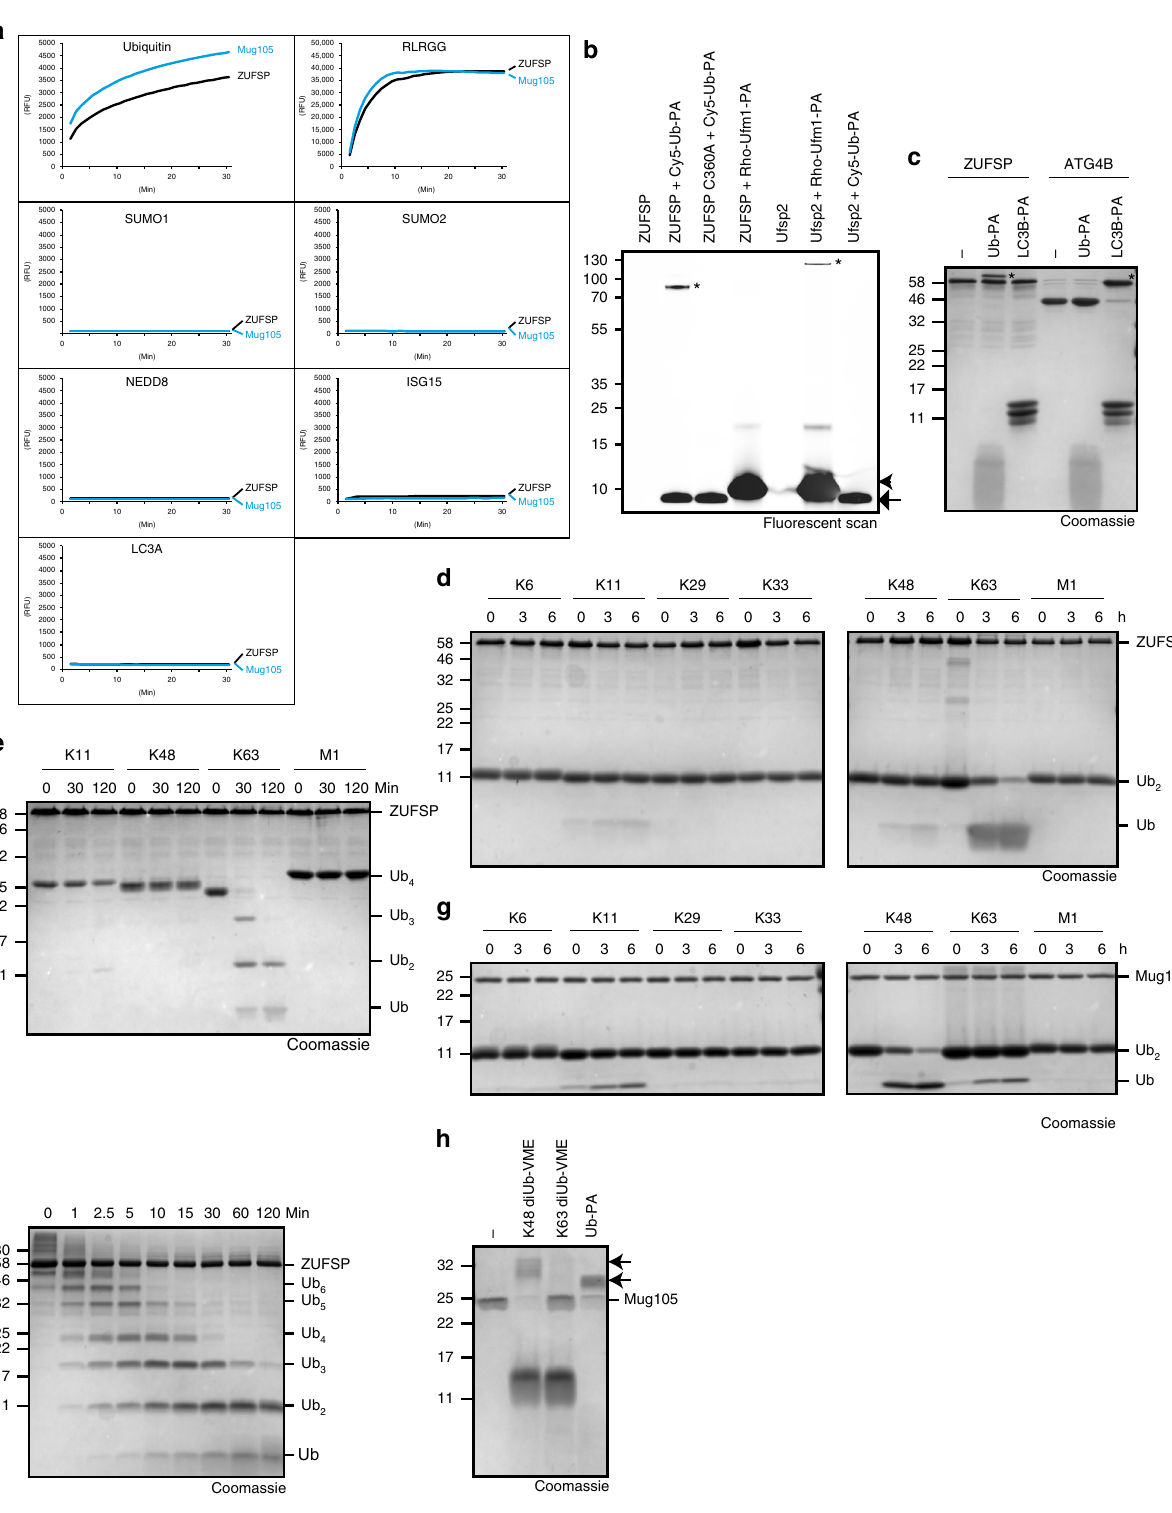
Fig. 2 ZUFSP and Mug105 are ubiquitin-speci fi c proteases with different chain speci fi city. a Activity assays with Ub-/UbL-AMC substrates shown as released fl uorescence (RFU) over time (min) with ZUFSP or Mug105. Shown RFU values are the means of triplicates. b Fluorescent scan of a suicide probe reaction of ZUFSP or Ufsp2 with Cy5-Ub-PA (arrow) and Rho-Ufm1-PA (arrowhead). Asterisks (*) mark the shifted band after reaction. c Suicide probe reaction of ZUFSP or ATG4B with Ub-PA and LC3B-PA. Asterisks (*) mark the shifted band after reaction. d , e Linkage speci fi city analysis with ZUFSP. A panel of di-ubiquitin ( d ) or tetra-ubiquitin ( e ) chains was treated with ZUFSP for the indicated time points. f Time course of cleavage of K63-linked Ub 6 + chains by full-length ZUFSP. g Linkage speci fi city analysis with Mug105. A panel of Ub 2 was treated with Mug105 for the indicated time points. h Suicide probe reaction with Mug105 and K48-diUb-VME, K63-diUb-VME or Ub-PA. Arrows mark the shifted bands after